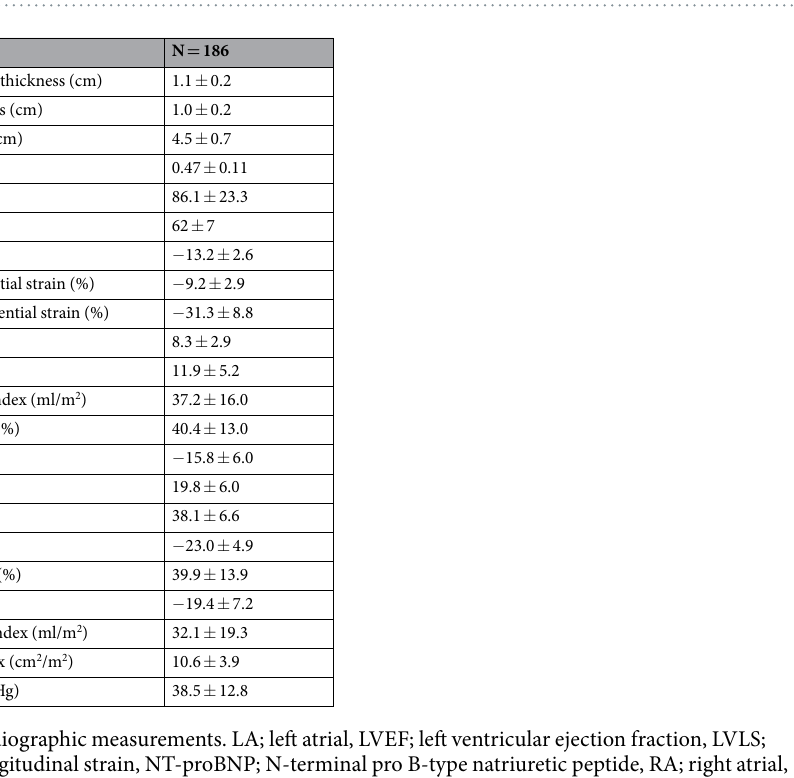
Table 2. Echocardiographic measurements. LA; left atrial, LVEF; left ventricular ejection fraction, LVLS; left ventricular longitudinal strain, NT-proBNP; N-terminal pro B-type natriuretic peptide, RA; right atrial, RVFAC; right ventricular fractional area change, RVSP; right ventricular systolic